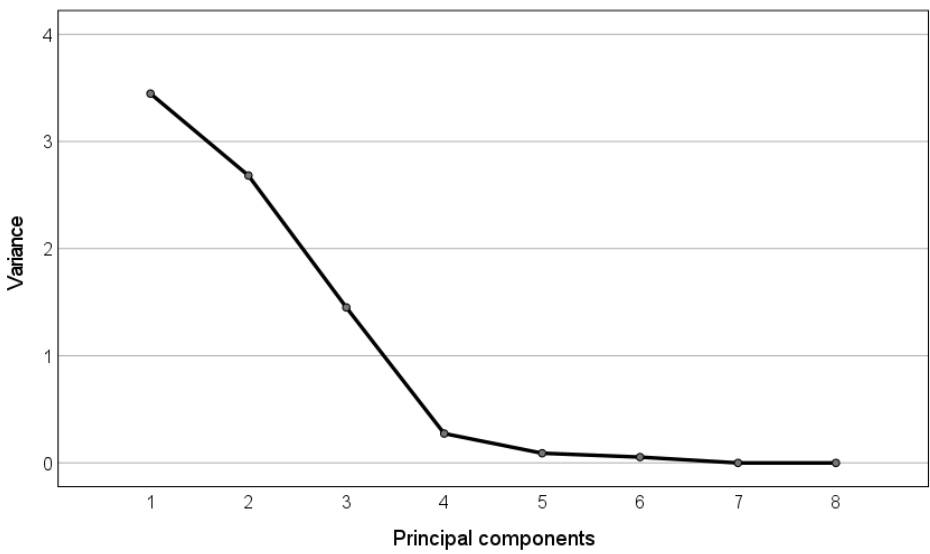
Figure 5. Eigenvalue spectrum for the PCA of the frequency-domain FHRV features.